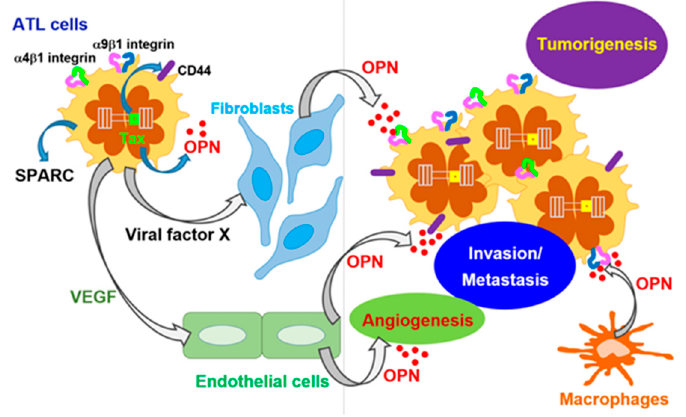
Figure 2. Proposed mechanisms of adult T-cell leukemia (ATL) tumorigenesis and metastasis. Table 1. Association of viral genes/oncogenes with the matricellular proteins.